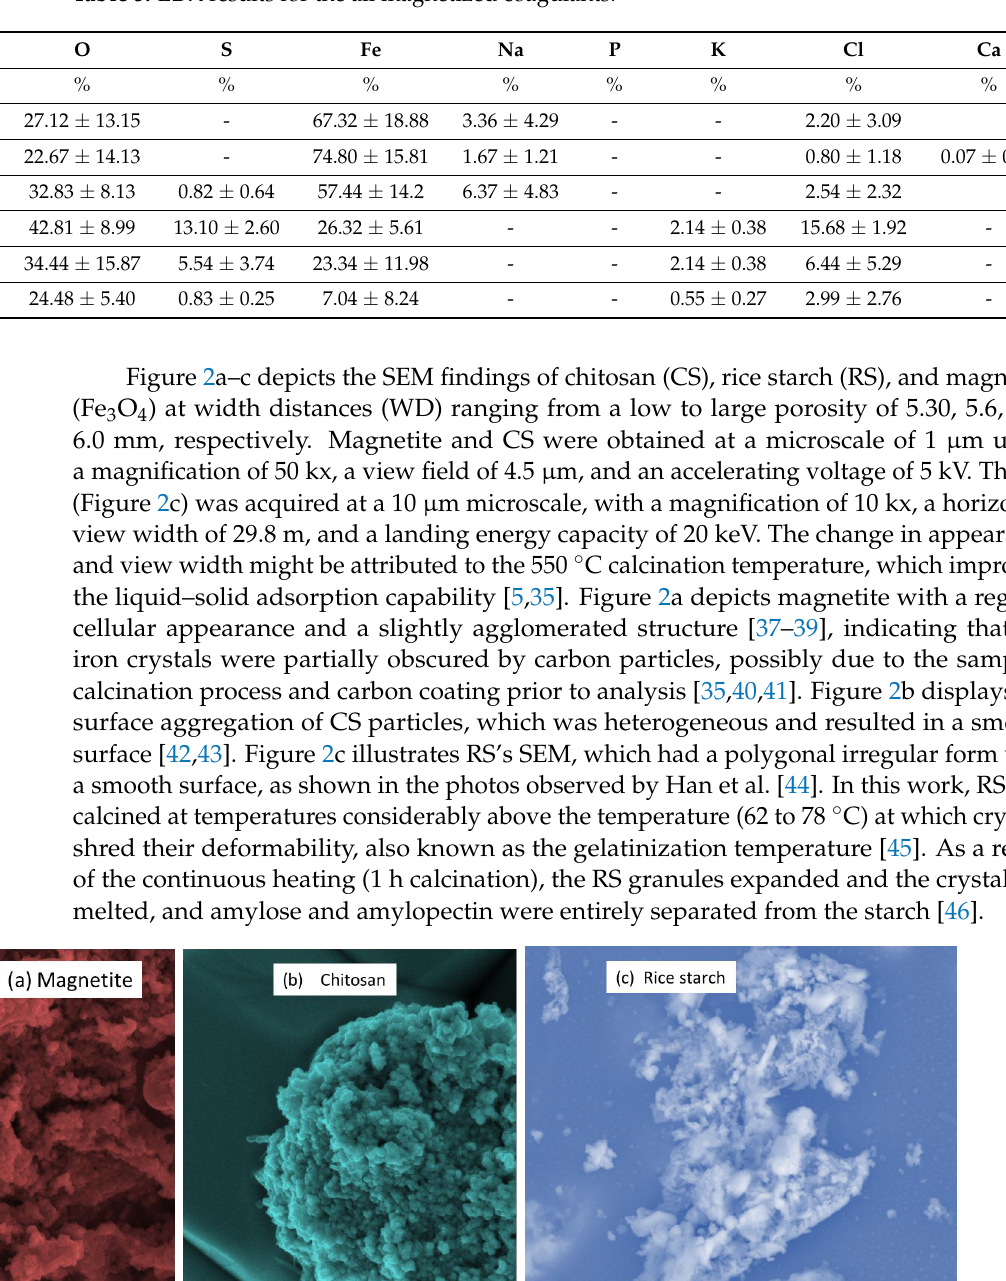
Table 5. EDX results for the all magnetized coagulants.